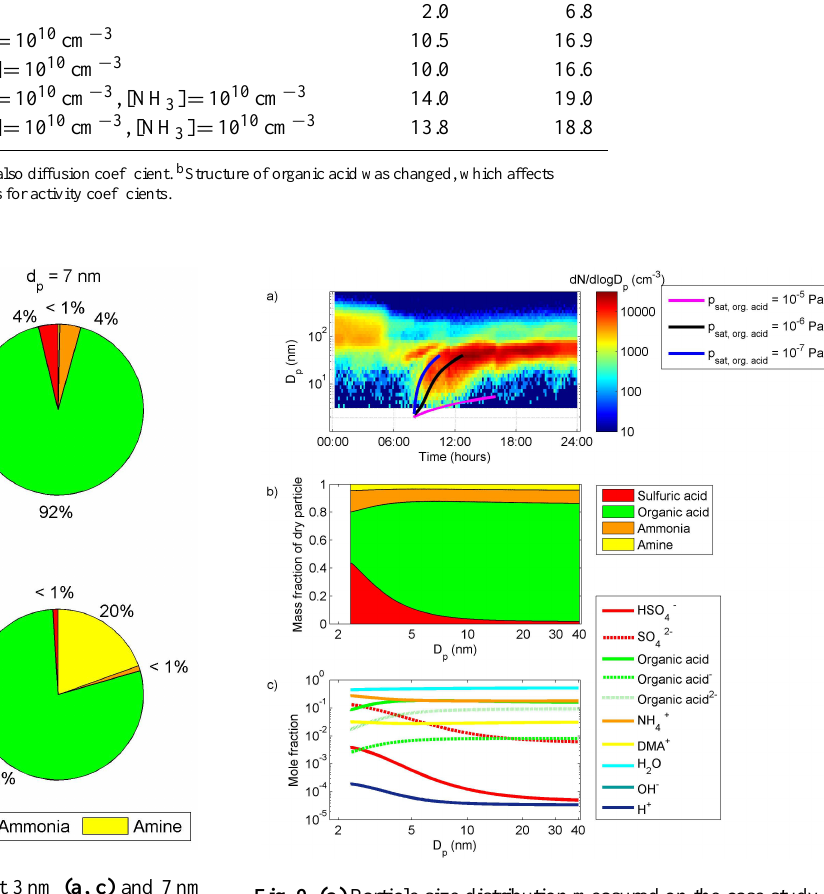
Fig. 9. (a) Particle size distribution measured on the case study day and particle size predicted with MABNAG using gas phase con- centrations estimated based on measurements and base case prop- erties for organic acid. Note that constant vapour concentrations were used in the model and the starting time for modelled parti- cle growth is not specified in the model. Dry particle mass frac- tions (b) and mole fractions (c) are shown for the model run with p sat , Org . acid = 10 − 6